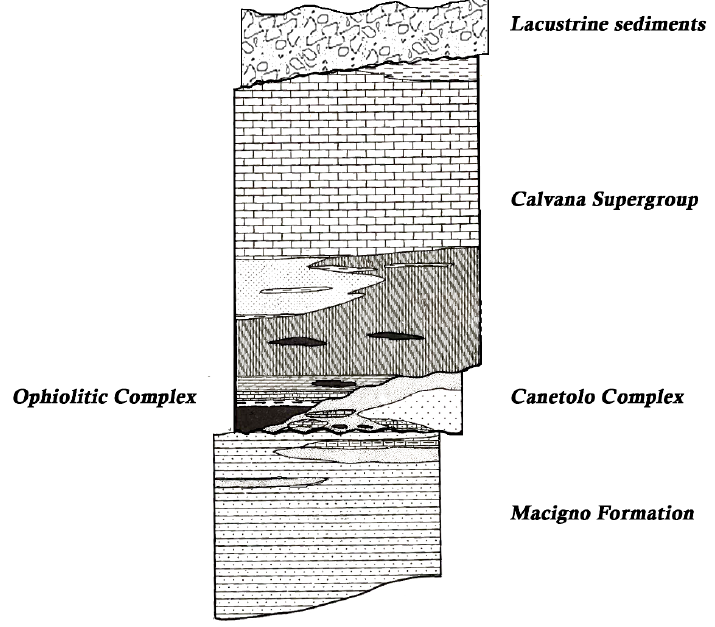
Figure 2. Sample of a stratigraphic column of the AoI (modified from [36]).